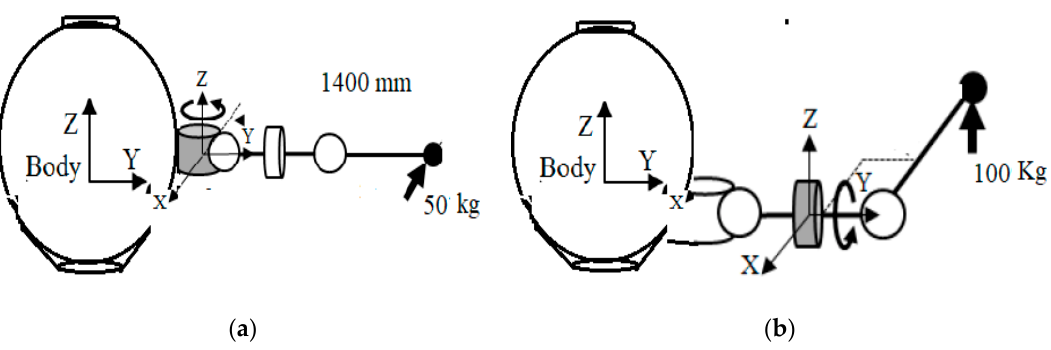
Figure 14. Extreme posture with the body supported by five legs, ( a ) payload joint 2, and ( b ) payload joint 4.